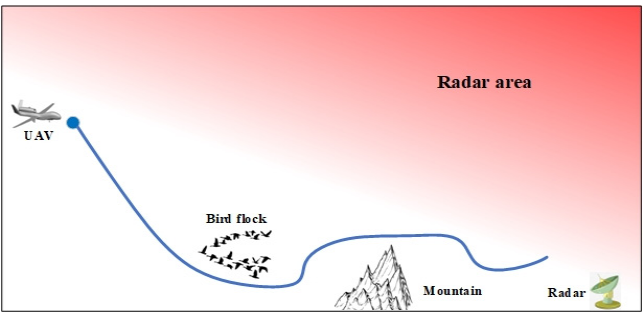
Figure 1. Schematic of battlefield environment.